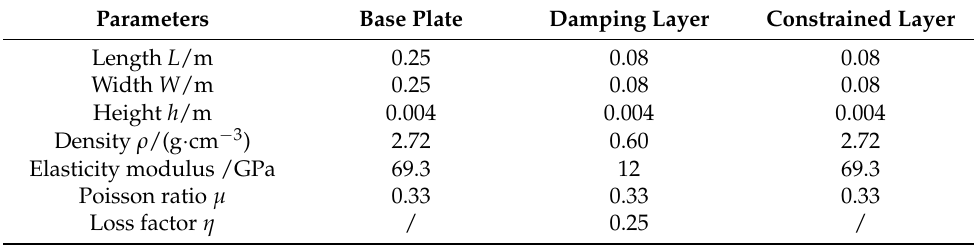
Table 2. Material and geometric parameters of composite